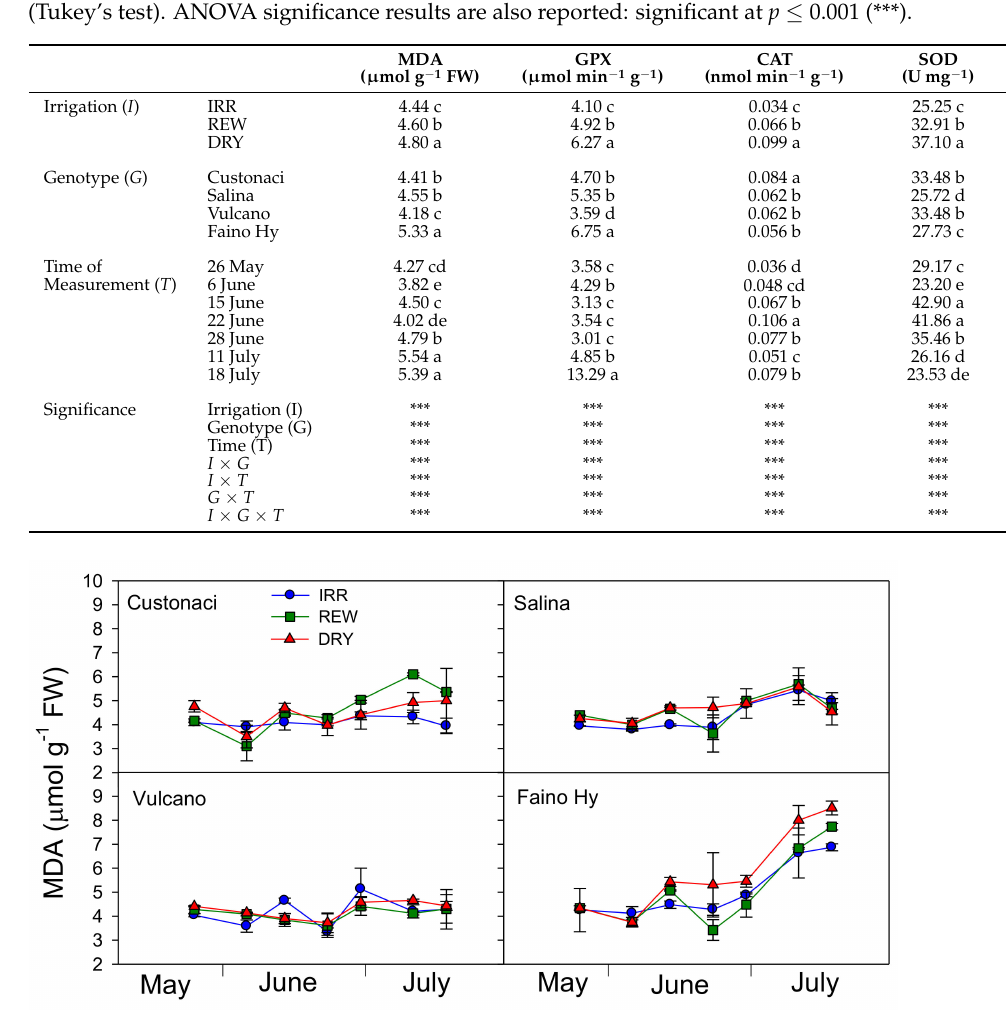
Figure 6. Malondialdehyde leaf content (MDA, µ mol g − 1 FW) in four genotypes of tomato in relation to the irrigation treatment (IRR: full irrigation; REW: rewatering; DRY: no irrigation). Vertical bars indicate the standard error ( n =